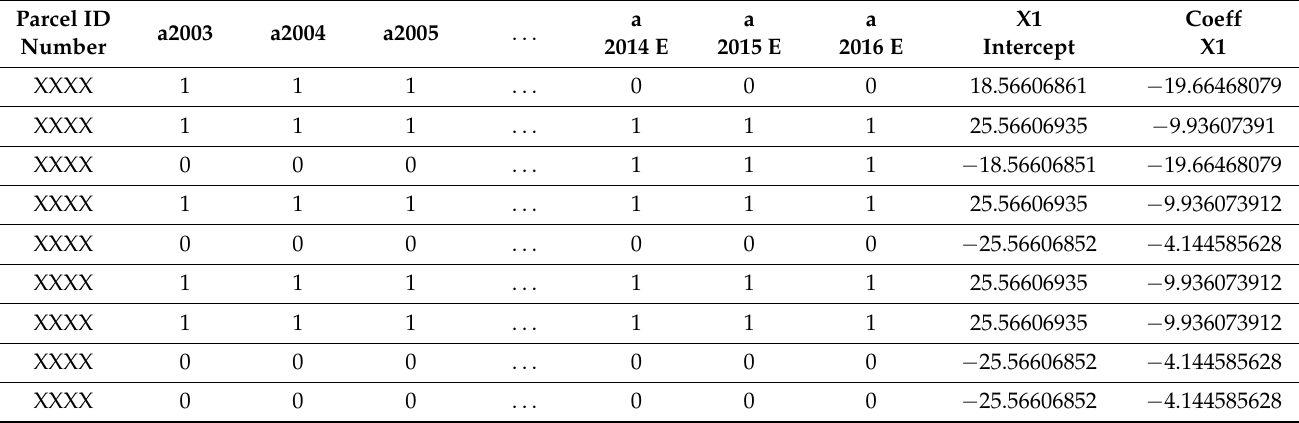
Table 3. An example illustrating the use of a time series of binary variables as basis for a regression. See text for further